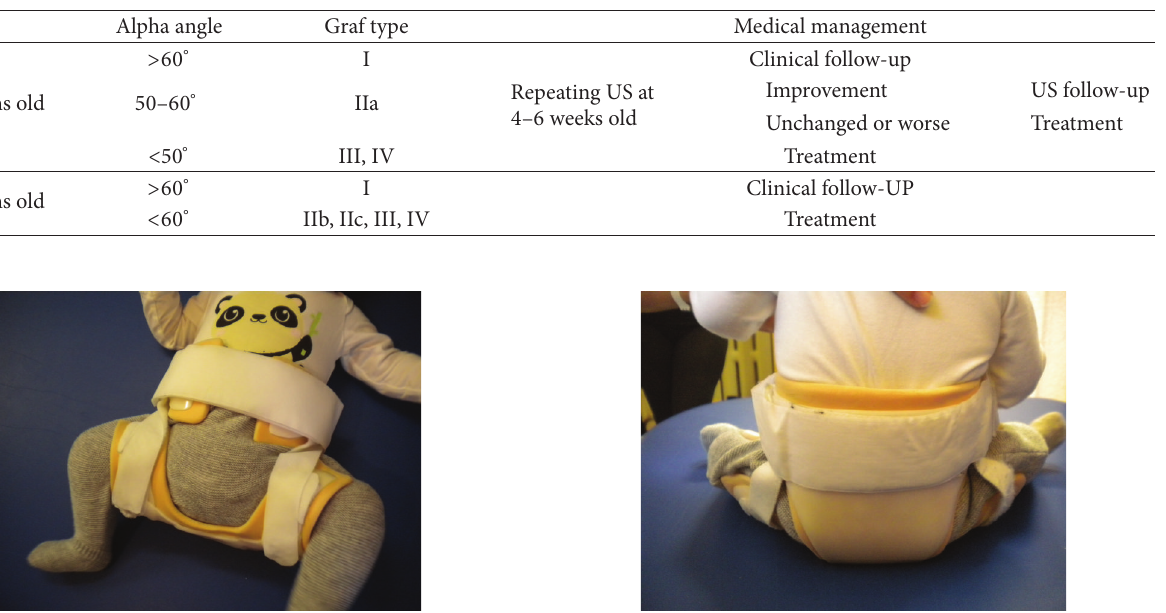
Table 2: US results and medical management: algorithm (adapted from Mahan et al. [21]).